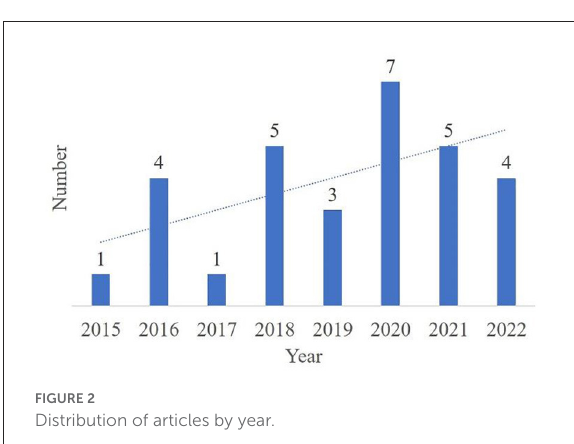
FIGURE2 Distribution of articles by